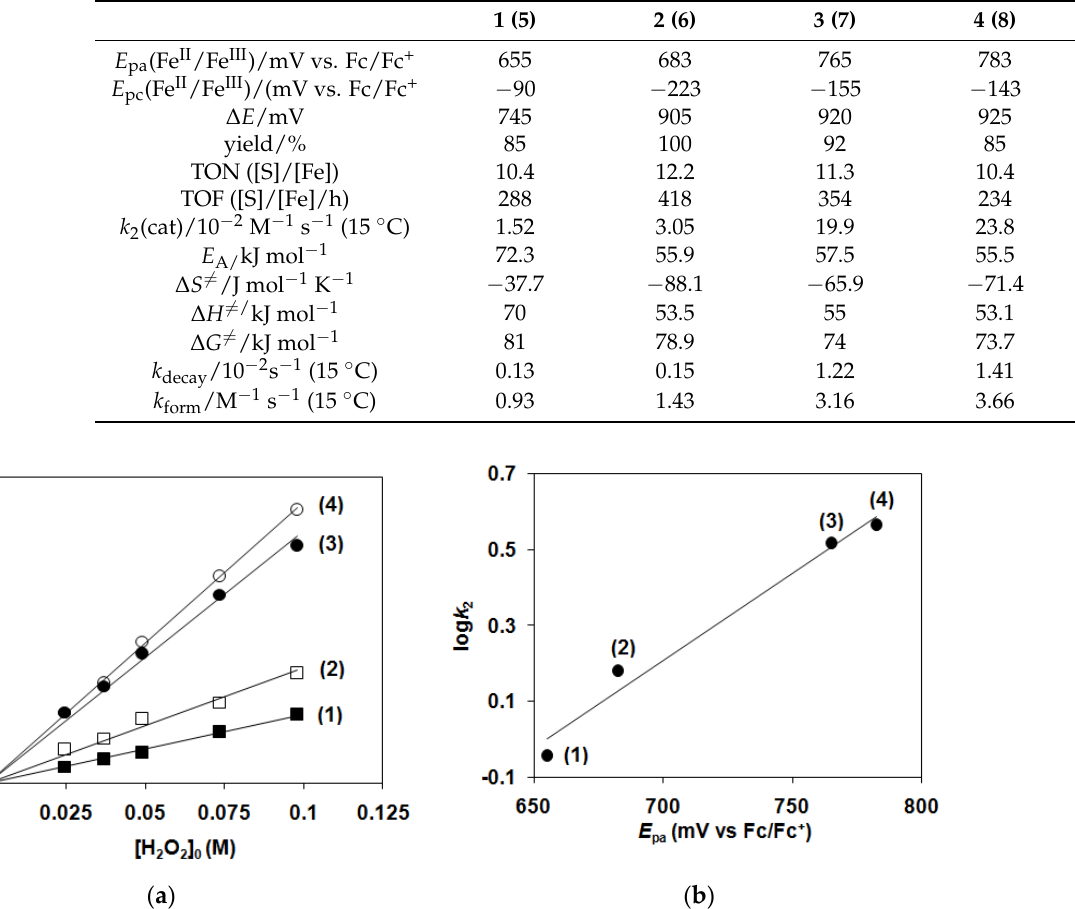
Figure 3. ( a ) Formation of diiron-peroxo ( 5 – 8 ) complexes. Plots of k obs against H 2 O 2 concentration to determine a second-order rate constant. [ 1 – 4 ] 0 = 2 mM, in CH 3 CN at 15 ℃ . ( b ) Dependence of the formation rate of peroxo-diiron complexes ( 5 – 8 ) on the oxidation potential ( E pa ) of the [Fe II (L 1–4 )(solvent) 3 ](ClO 4 ) 2 ( 1 – 4 ) complexes.